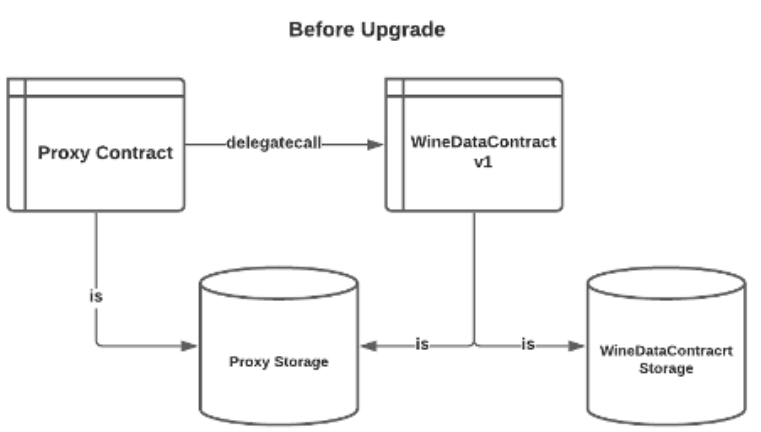
Figure 15. EVM Assembly Code with delegatecall.